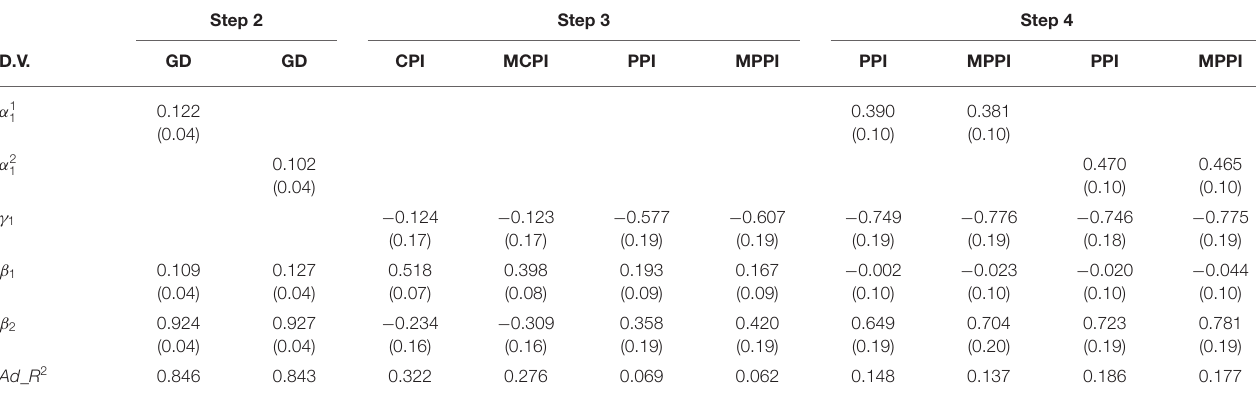
TABLE 7 | The test results for the government debt channel.